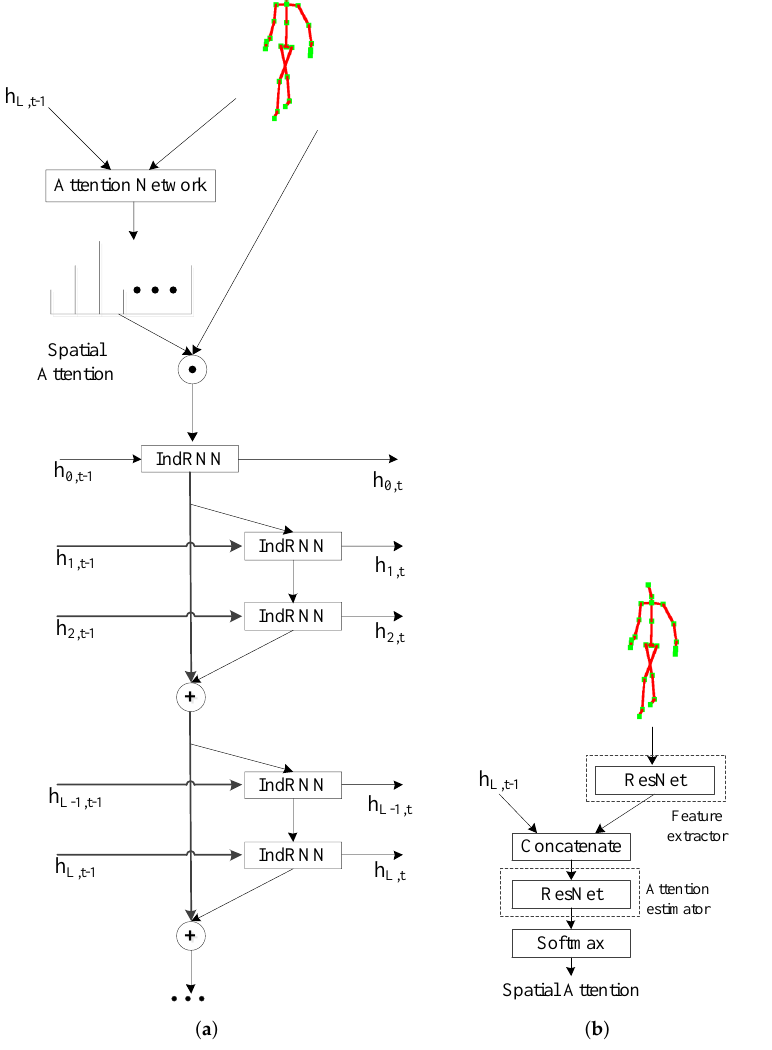
Figure 1. The framework of the spatial IndRNN-based attention models for skeleton-based action recognition. ( a ) The attention network obtains the attention based on the last hidded state and the current input. The main classification network is a deep residual IndRNN network where each residual block contains two IndRNN layers. ( b ) Illustration of the attention network used to process the input and the last hidden state from